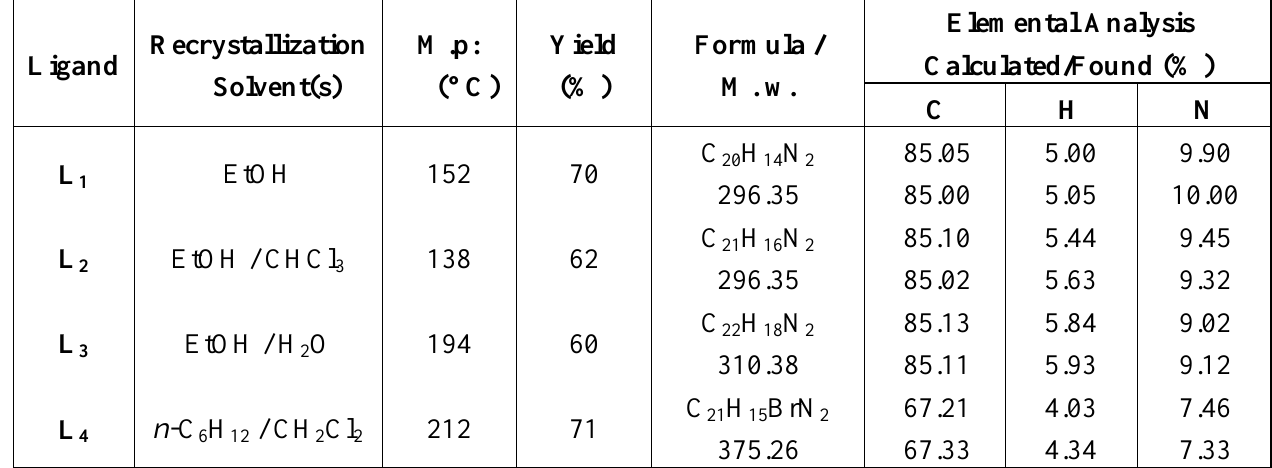
Table III. Melting points, yield and elemental analyses of ligands L